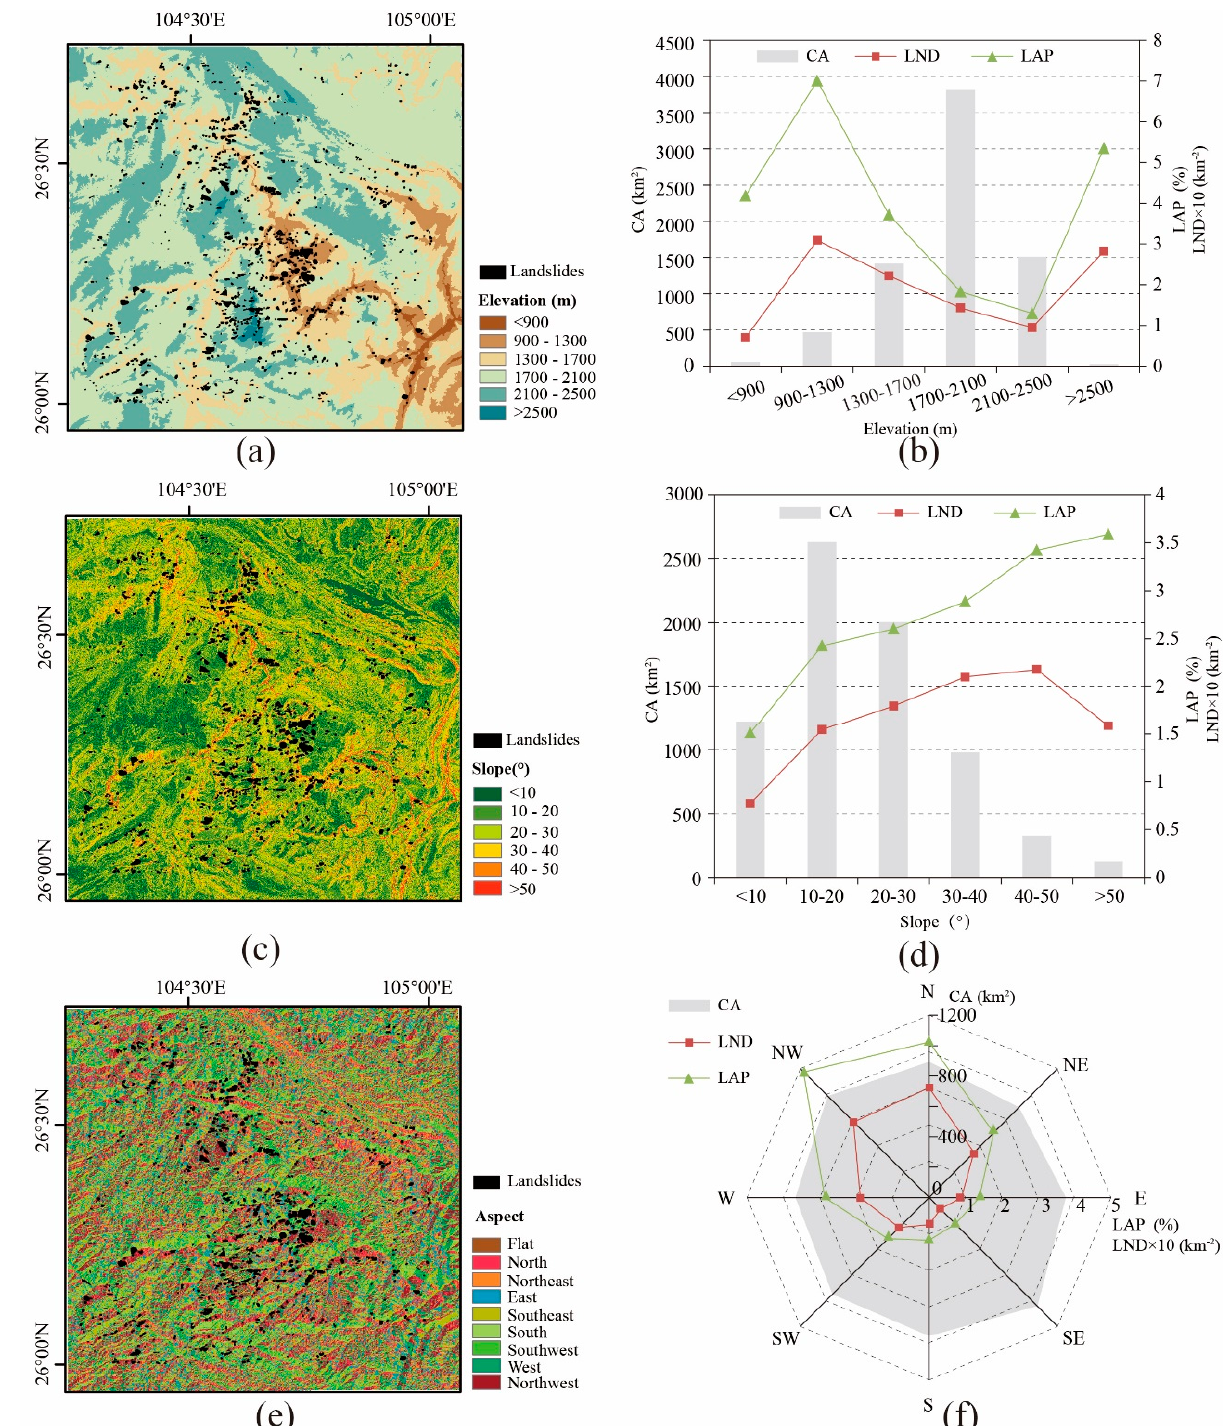
Figure 8. Distribution ( left ) and correlation ( right ) of landslides with different topographic factor classifications using landslide area percentage (LAP) and landslide number density (LND). ( a , b ) Elevation; ( c , d ) Slope angle; ( e , f ) Aspect. CA: classification area.